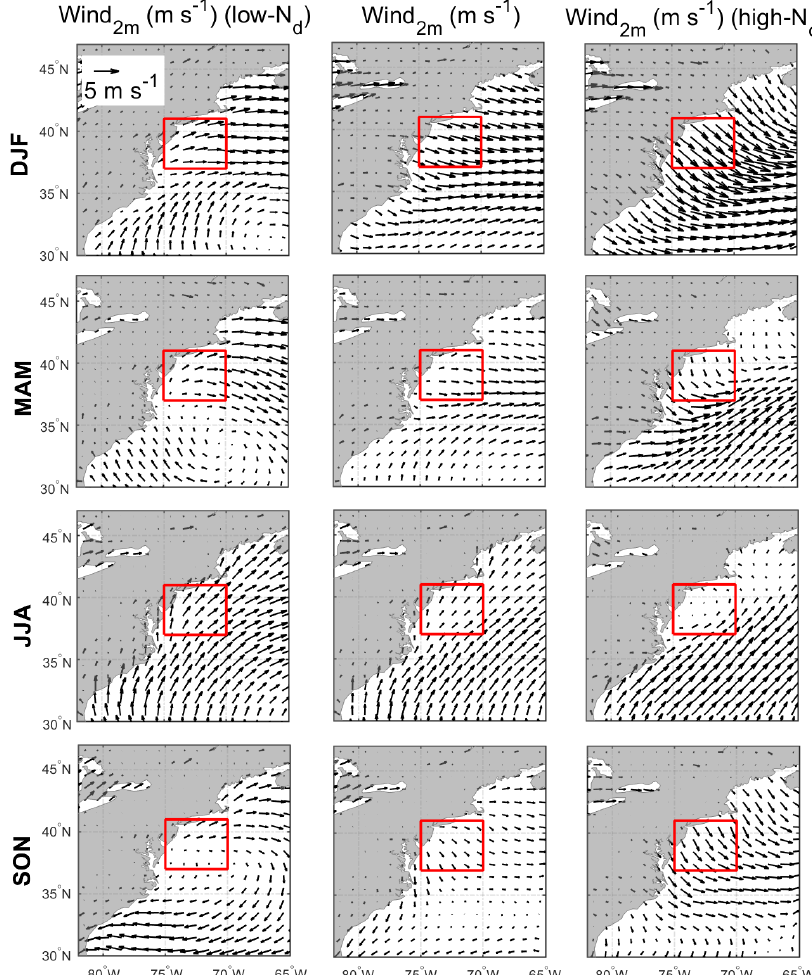
Figure 9. Seasonal climatology of near-surface (2m above ground) wind speed (middle column) and mean values for low- N d days (left column) and high- N d days (right column). The reference wind vector is shown in the top left panel. The red box represents sub-domain C-N for which the analysis was